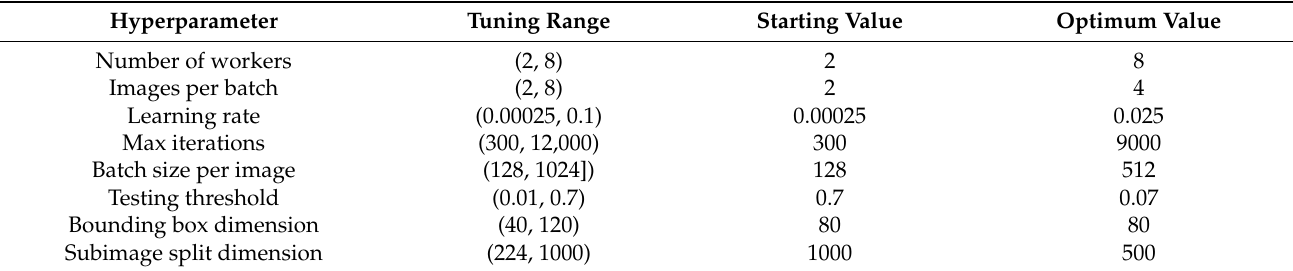
Table 4. Detectron2 hyperparameter